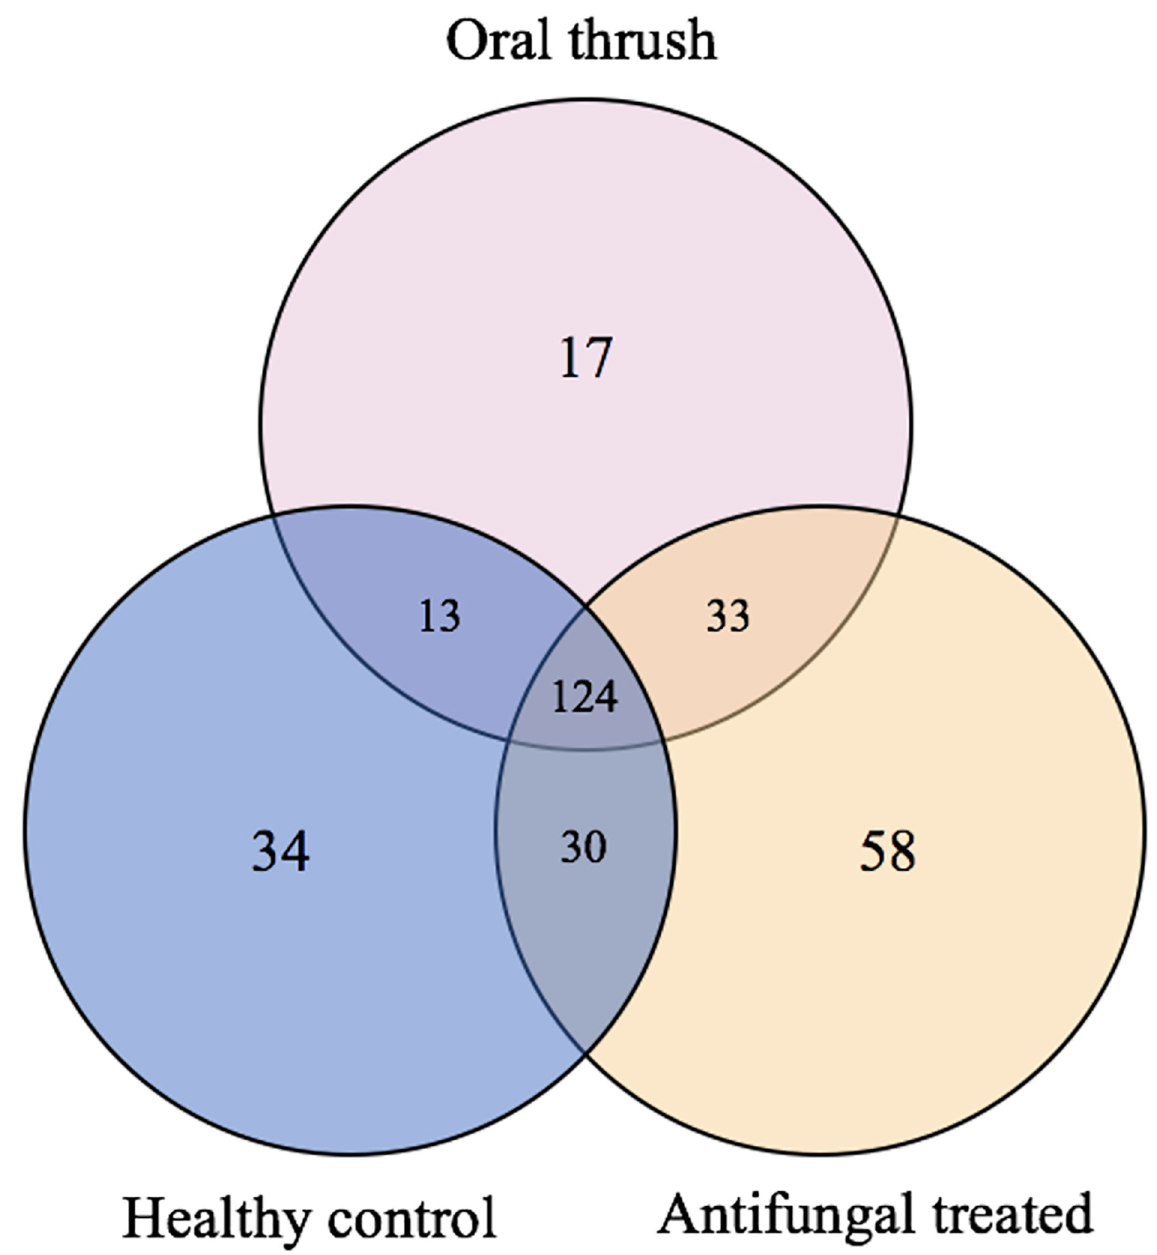
Fig 3. Venn diagram illustrating the number of shared and distinct species in the oral mycobiota of oral thrush, healthy control, and follow-up participant oral rinse samples.